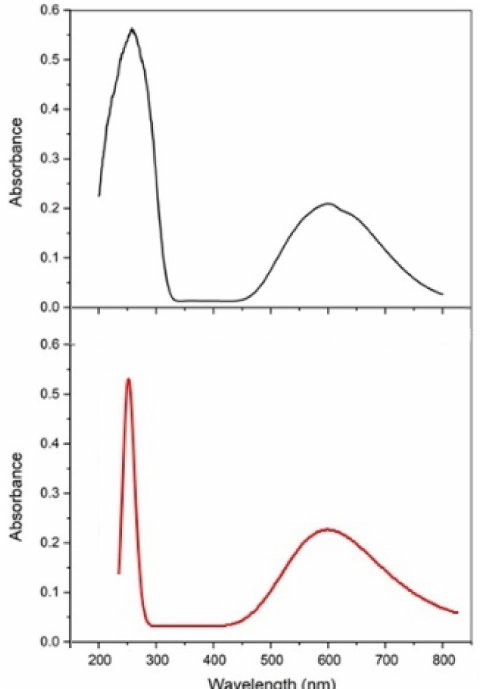
Figure 5. UV-Vis experimental spectrum of [Cu(Citr) 2 ] n obtained by diffuse reflectance (black line) and calculated spectrum at the level of theory mPW1PW91/6-31G(d)-LANL2DZ and ECP=LANL2DZ (red